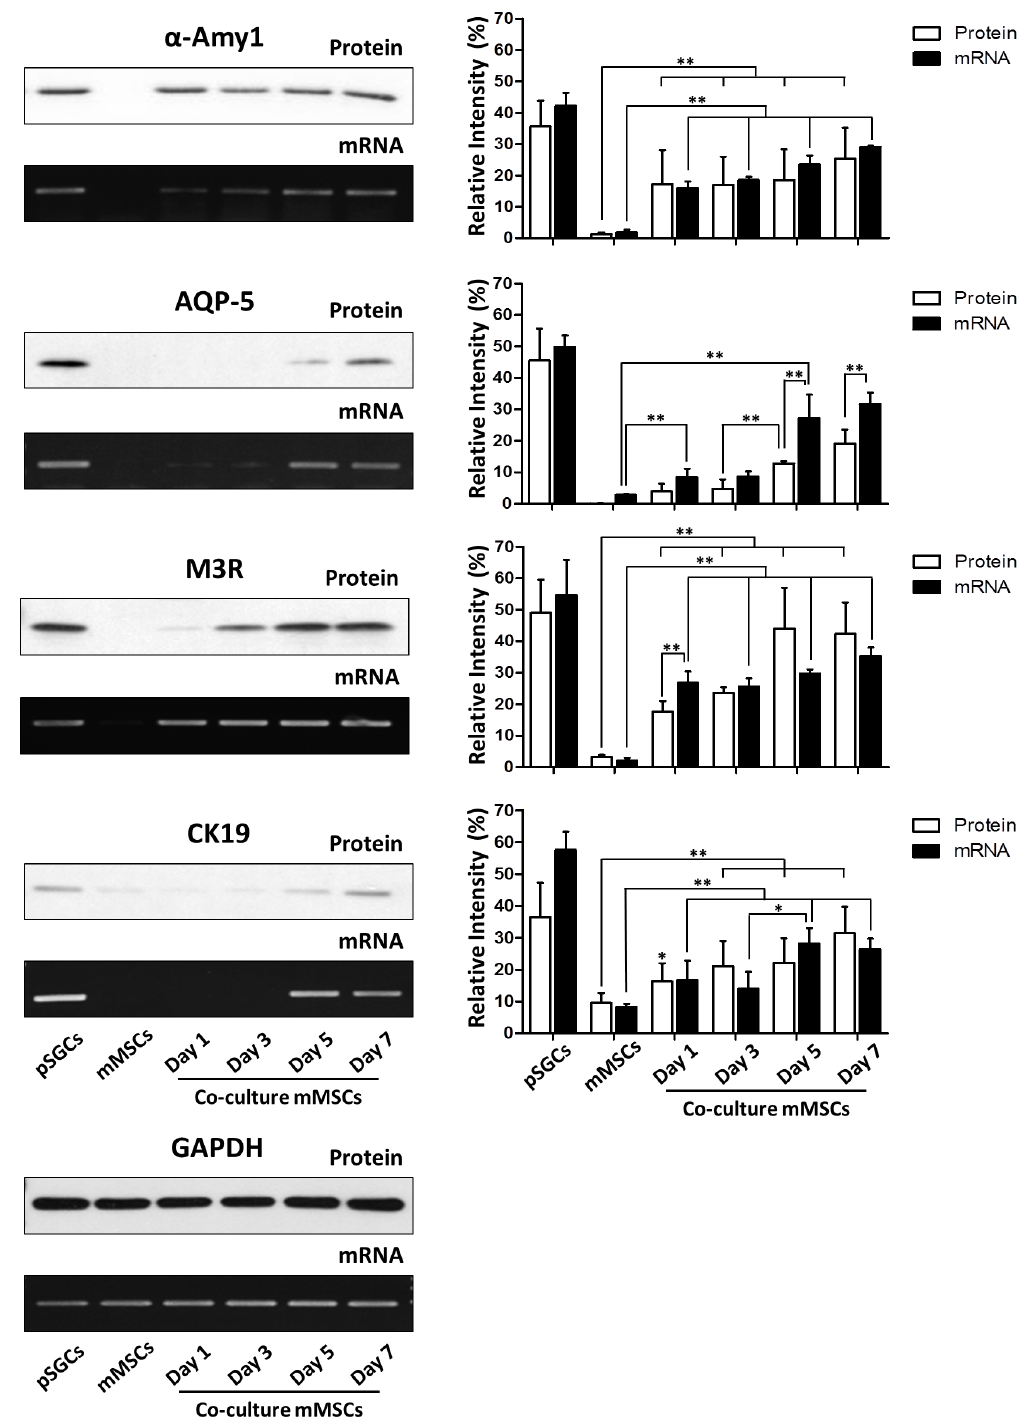
Figure 2. Specific salivary epithelial cell markers were expressed in co-cultured mMSCs, as detected by western blotting and RT- PCR analysis of cell-specific markers. Total protein lysate and mRNA samples isolated from pSGCs from 4 week-old B6 mice were used as a positive control. mMSCs without co-culture was used as a negative control. Acinar markers of salivary specific a -AMY, M3R and AQP-5 were detected in pSGCs and co-cultured mMSCs. Densitometer analyses of the expressed proteins and genes in three independent replicates(*p , 0.05, **p , 0.01, one-way ANOVA with Bonferroni post-hoc test).